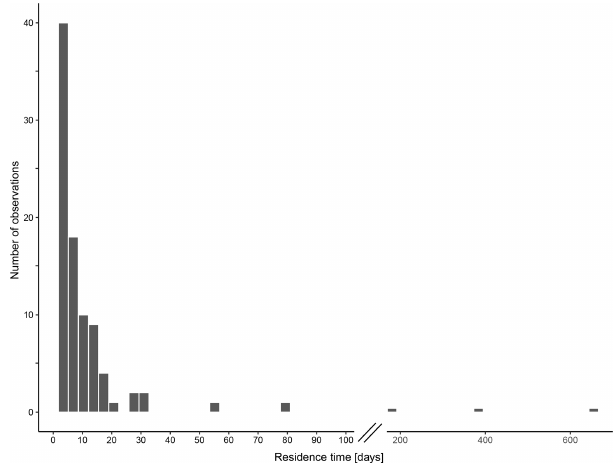
Figure 12. Residence time of empty shells of N. pachyderma within the productive zone in days, calculated based on the standing stock within the productive zone and the shell flux below the base of the productive zone, calculated with average shall masses below the productive zone. Consider the break in the x axis between 100 and 200d.